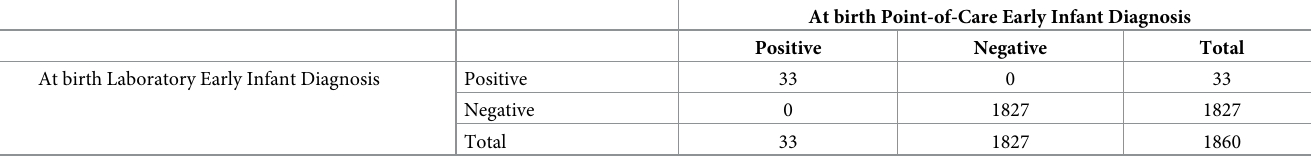
Table 2. Results of at birth point-of-care testing with the Alere q HIV-1/2 Detect system compared with reference birth laboratory testing using the Roche CAP/ CTM Qualitative HIV-1